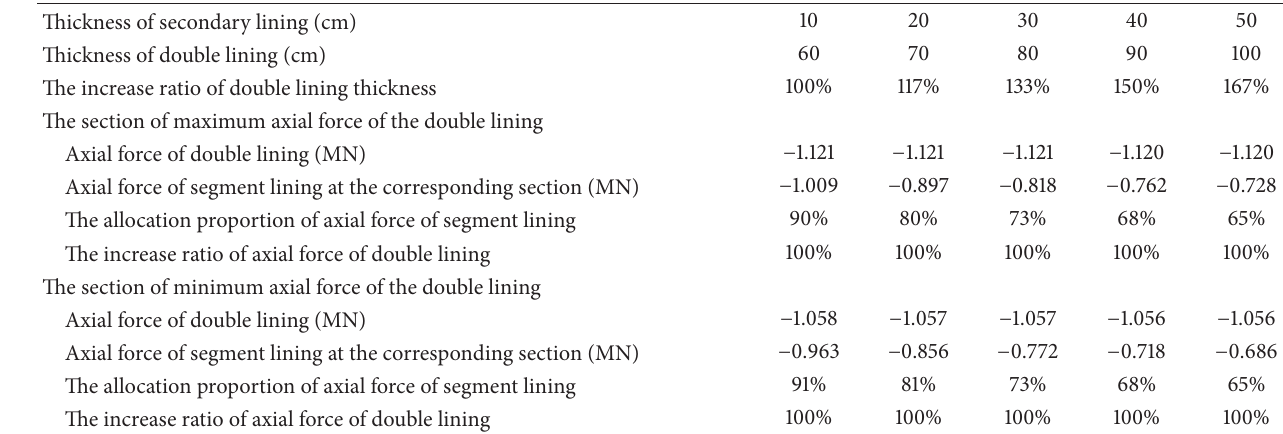
Table 9: The axial force extreme values under different thicknesses of secondary